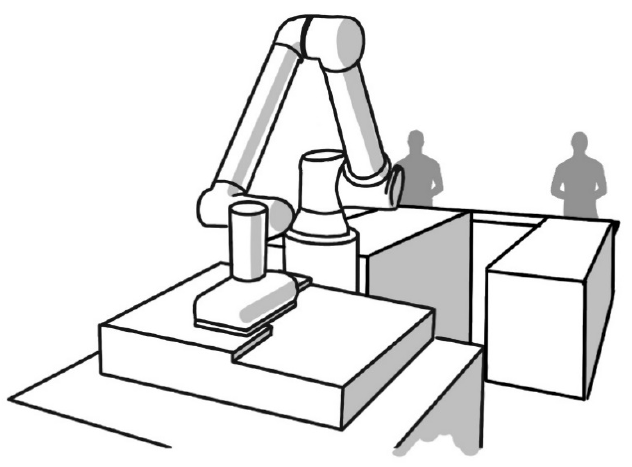
Figure 12. Hybrid workstation conceptualization.